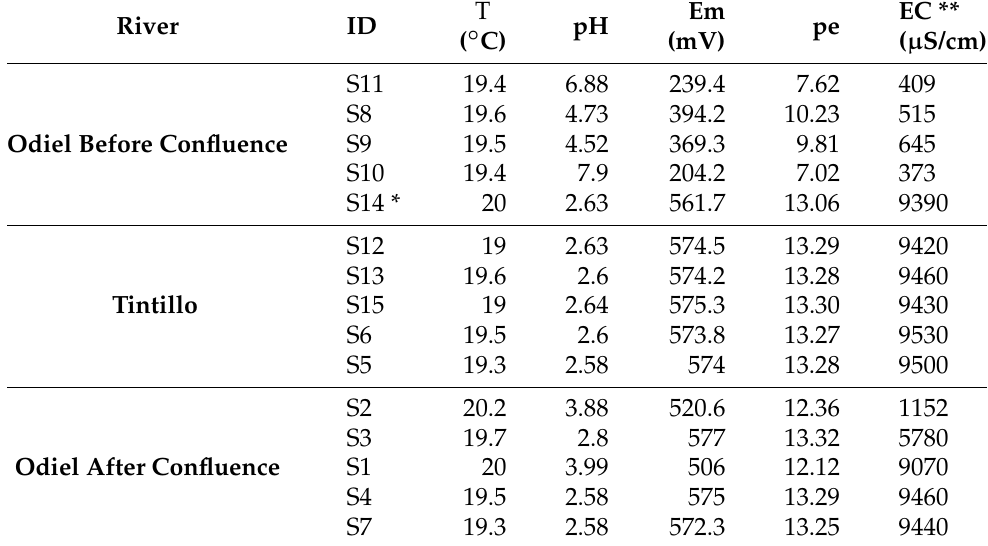
Table A1. Field parameters of natural stream waters of the Odiel and Tintillo River confluence. Em, redox potential measured with platinum/reference electrode; pe, redox corrected and expressed as electron activity; (**) EC, electrical conductivity measurements laboratory-based; (*) S14 is located in the left border of Odiel River, which shows Tintillo waters already affecting its composition.